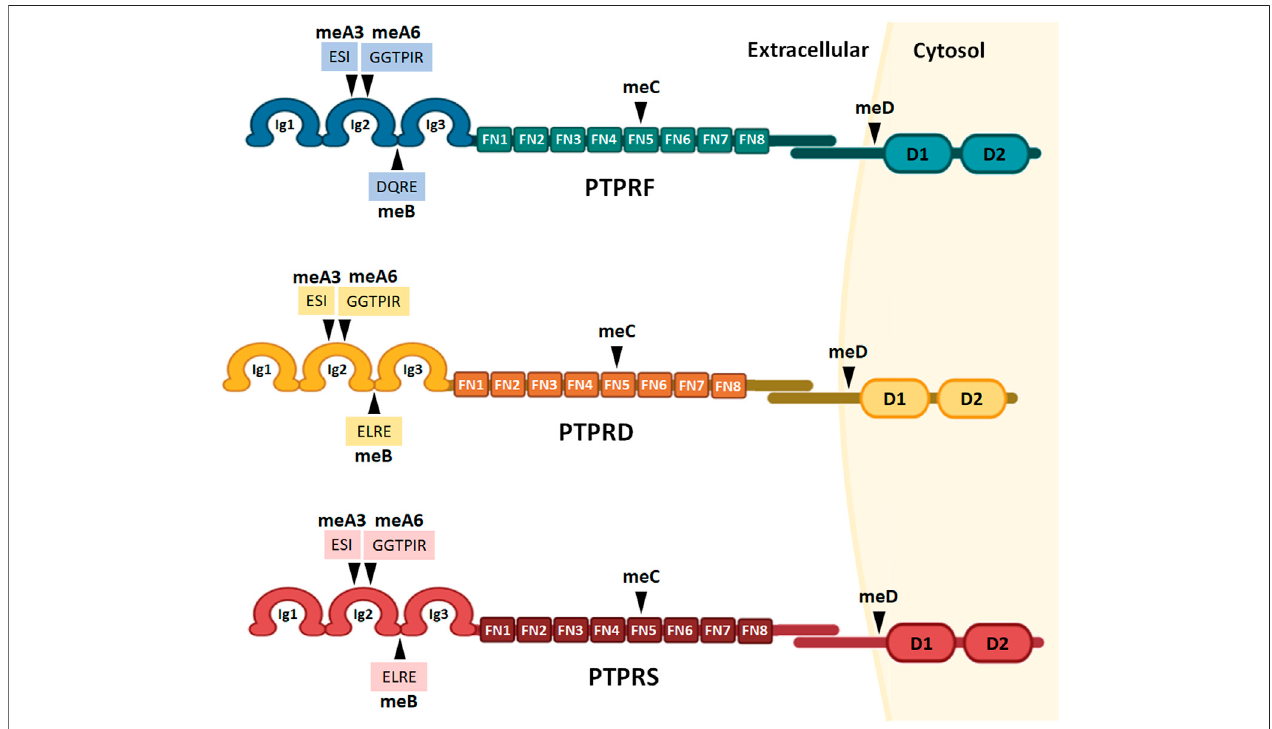
FIGURE 1 | LAR-RPTPs protein structure and alternative splicing sites. The structure of all three receptors consists of an extracellular portion of three Ig-like domainsandeightextracellular fi bronectintypeIIIdomains, atransmembraneregion,andtwointracellularproteintyrosinephosphatasedomains:amembraneproximal catalyticallyactive domain and amembranedistaldomain withno phosphataseactivity. Alternative splicingsites aremarked asmini-exonsmeA-D, and the aminoacidic sequences of meA3, meA6 and meB are shown. Ig: Ig-like domains; FN: fi bronectin type III domains; D1 and D2: phosphatase domains.